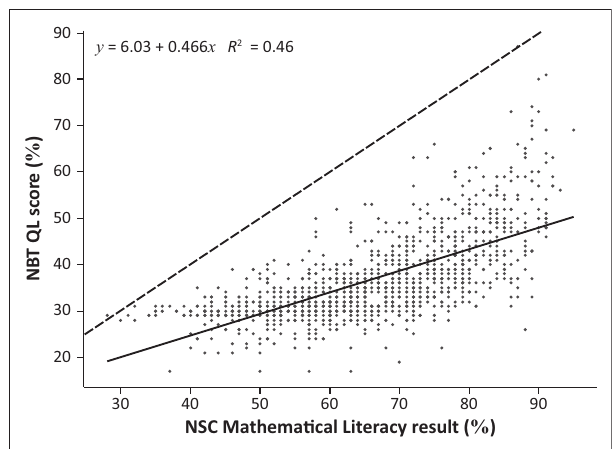
The dotted line indicates the positions where the scores are equal and the solid line is the linear regression line. FIGURE 6: National Senior Certificate Mathematical Literacy and National Benchmark Test quantitative literacy scores ( N = 1